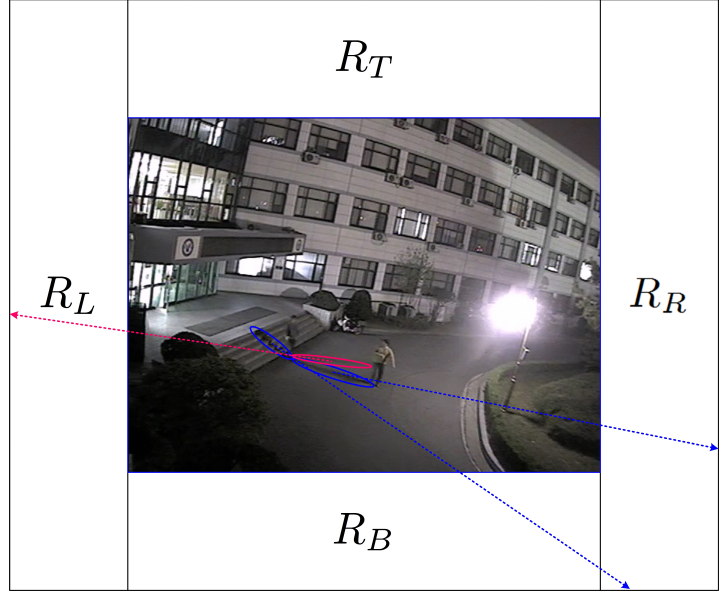
Figure 10. Possible regions of light sources for the proposed shadow detection